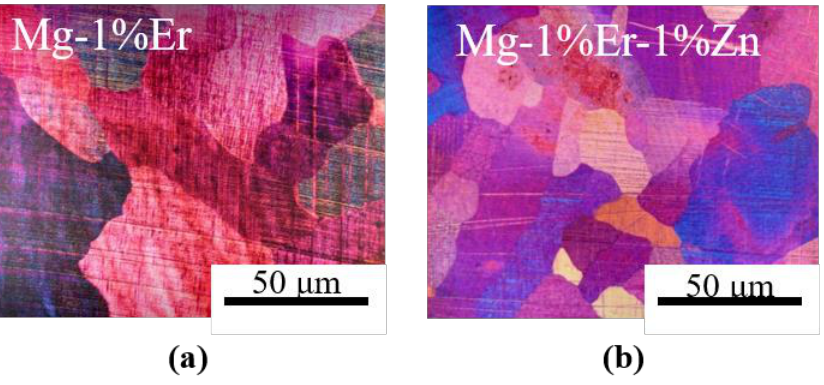
Figure 1. Micrographs of Mg-1%Er ( a ) and Mg-1%Er-1%Zn ( b ) after casting. Table 1. Chemical composition in atomic and weight percentage of Mg-1%Er and Mg-1%Er-1%Zn. Alloys Mg (wt %/at %) Er (wt %/at %) Zn (wt %/at %) Mg-Er 99.04 99.86 0.96 Mg-Er-Zn 98.01